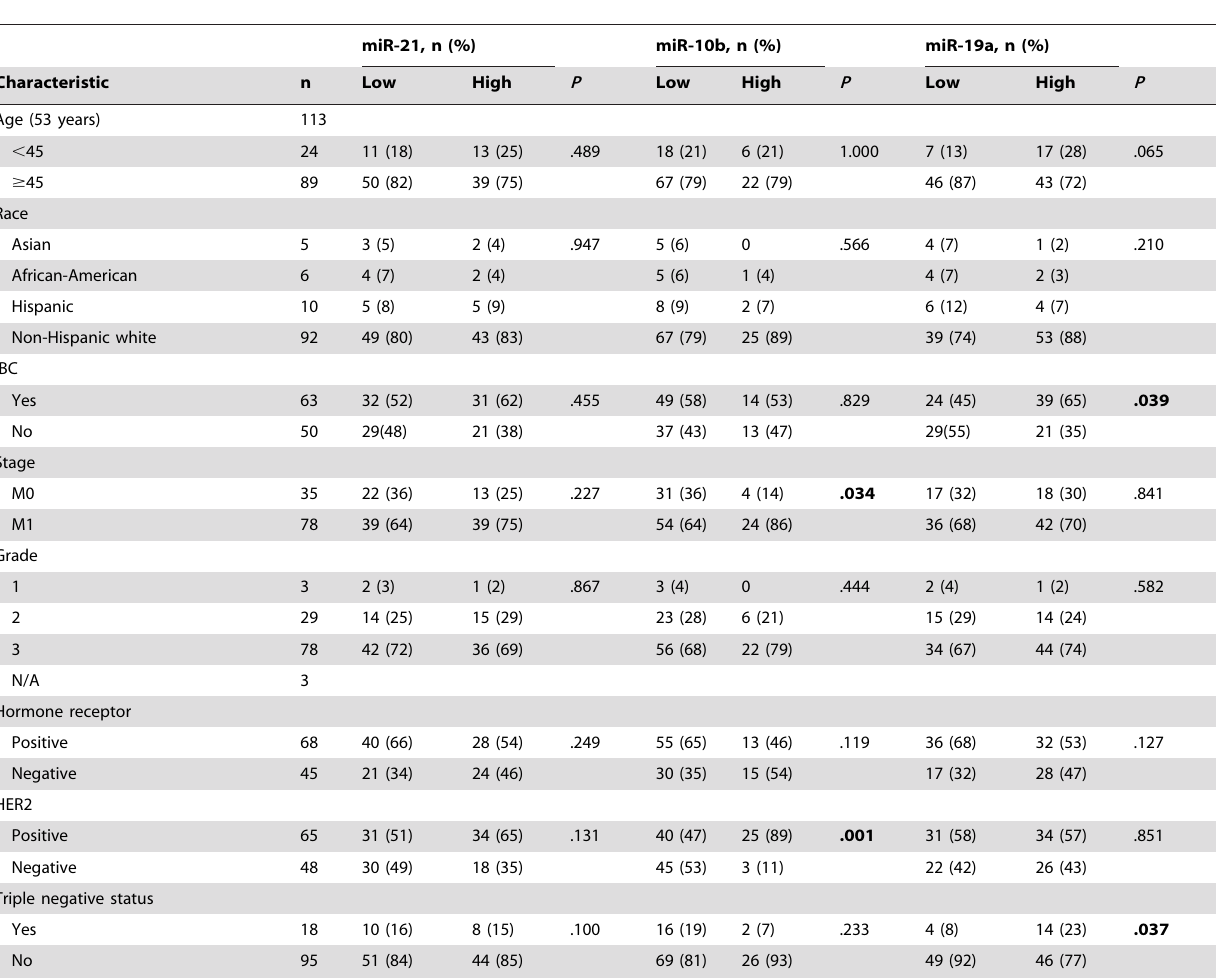
Table 1. Clinical characteristics of breast cancer patients at the beginning of the study and their association with serum miR-21, miR-10b, and miR-19a